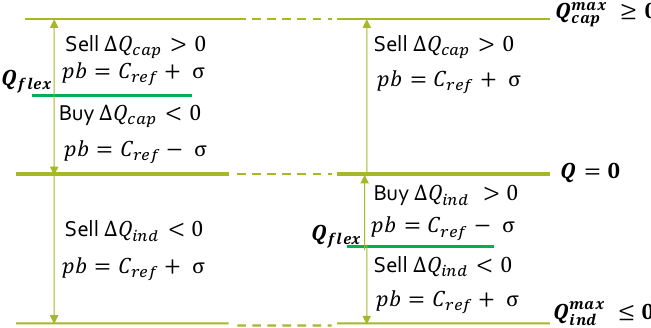
Figure 5. Costs of providing reactive power for PV and wind farms.